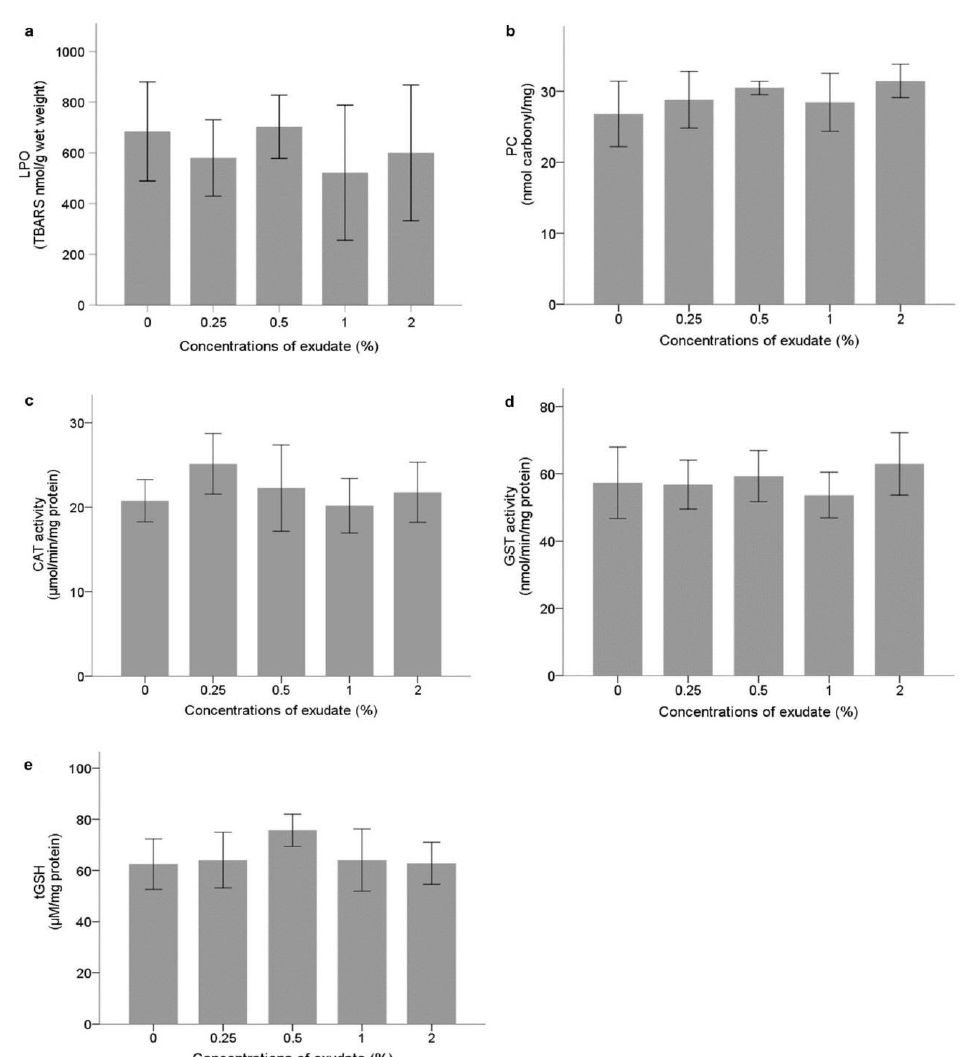
Figure 1. Oxidative stress biomarkers of Mytilus galloprovincialis digestive gland after 96 h of exposure to Asparagopsis armata exudate. ( a ) Lipid Peroxidation (LPO); ( b ) Protein Carbonylation (PC); ( c ) Catalase (CAT); ( d ) Glutathione-S-Transferase (GST); ( e ) Total Glutathione (tGSH). All values are presented as mean ± SE.